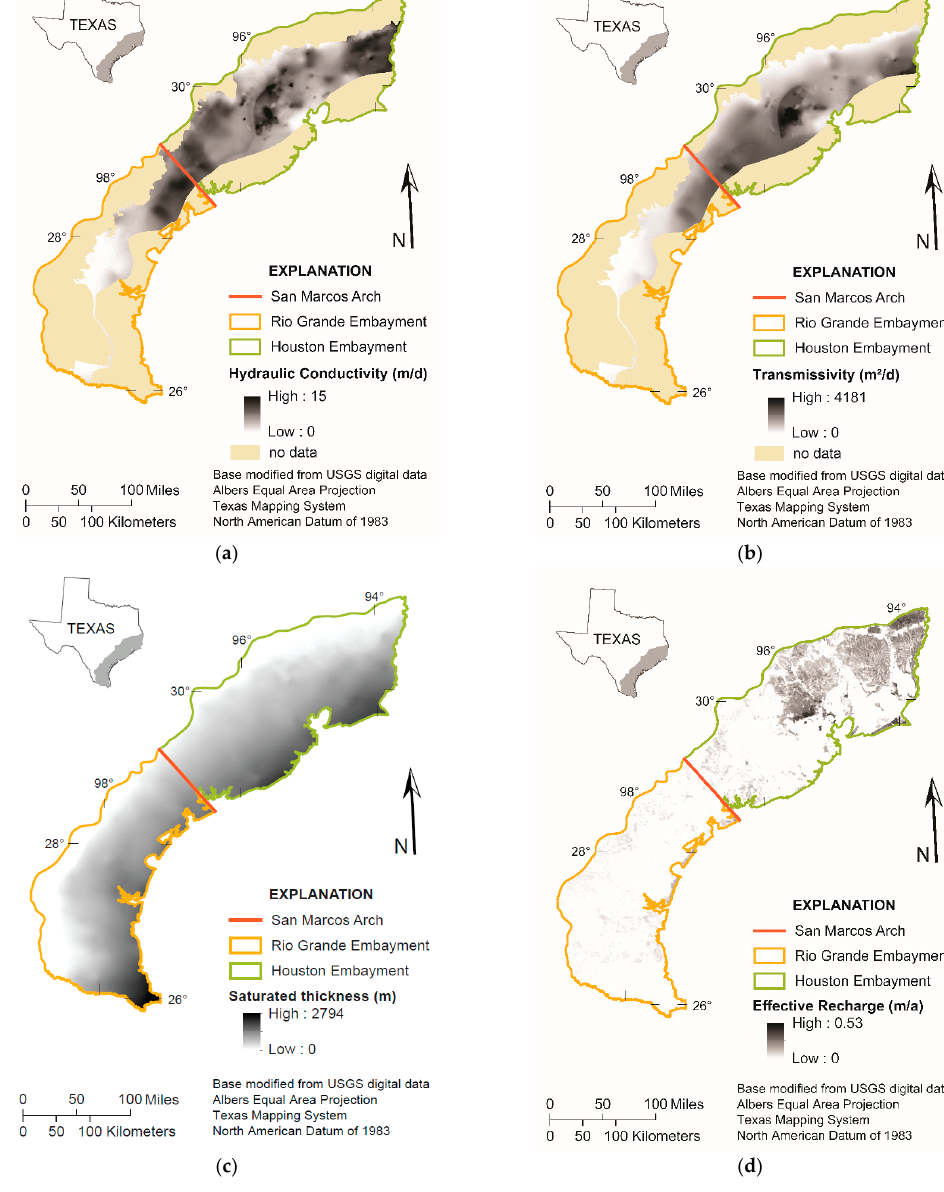
Figure 4. Maps of equivalent ( a ) hydraulic conductivity, ( b ) transmissivity, and ( c ) saturated thickness for the composite aquifer system (Aquifers: Alluvial, Chicot, Evangeline) in the assessment unit [9,10]. Map of ( d ) effective recharge [8] within the permissive tract; the maximum effective recharge of 0.53 m/a is found in the Houston Embayment.